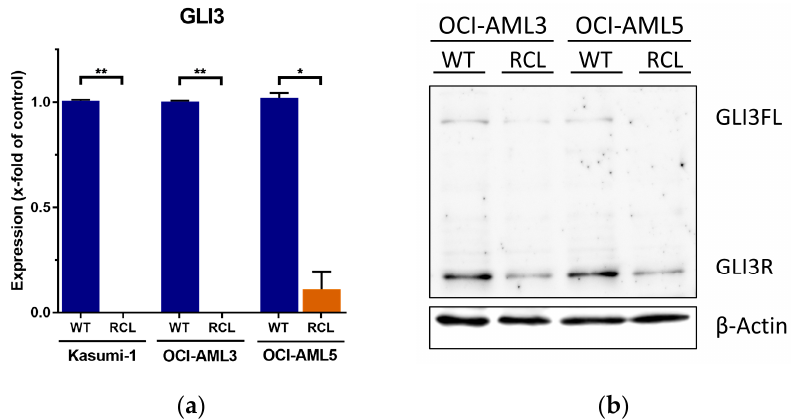
Figure 2. Downregulation of GLI3 in Ara-C resistant cell lines. ( a ) WT and Ara-C-RCL Kasumi-1, OCI-AML3, and OCI-AML5 were analyzed for GLI3 mRNA levels by RT-qPCR analysis; * p < 0.05 and ** p < 0.01 in Welch’s t -test. ( b ) Western blot of full length GLI3 (GLI3FL) and its repressor form (GLI3R) in WT and RCL variants of OCI-AML3 and OCI-AML5.